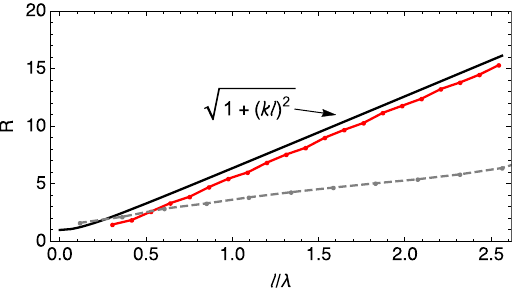
FIG. 8. Transformer ratio. Solid black line is the same as in Fig. 2. The dot-solid and dot-dashed lines correspond to cases (c) and (d) in Fig. 7.